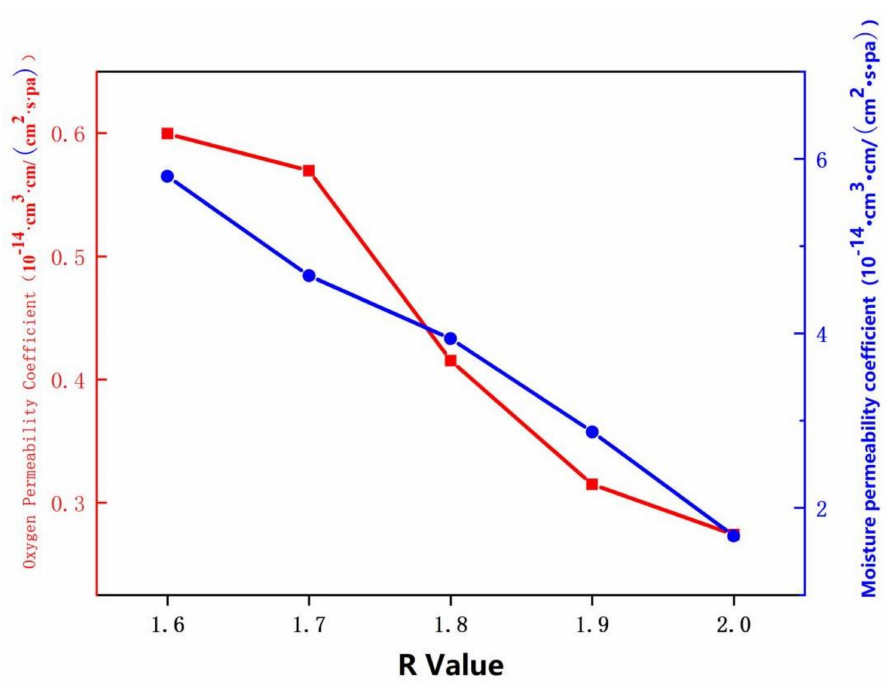
Figure 13. Oxygen permeability of SPU films with different R values.